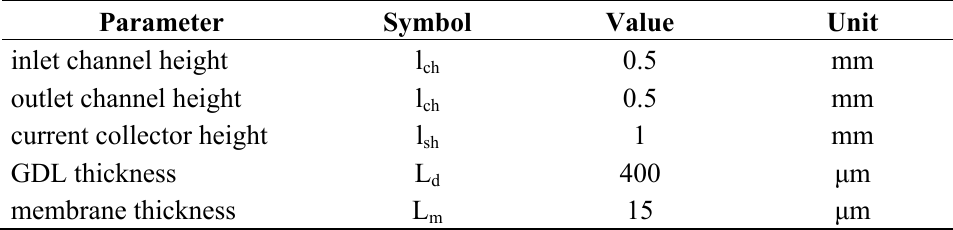
Table 5. Model geometric